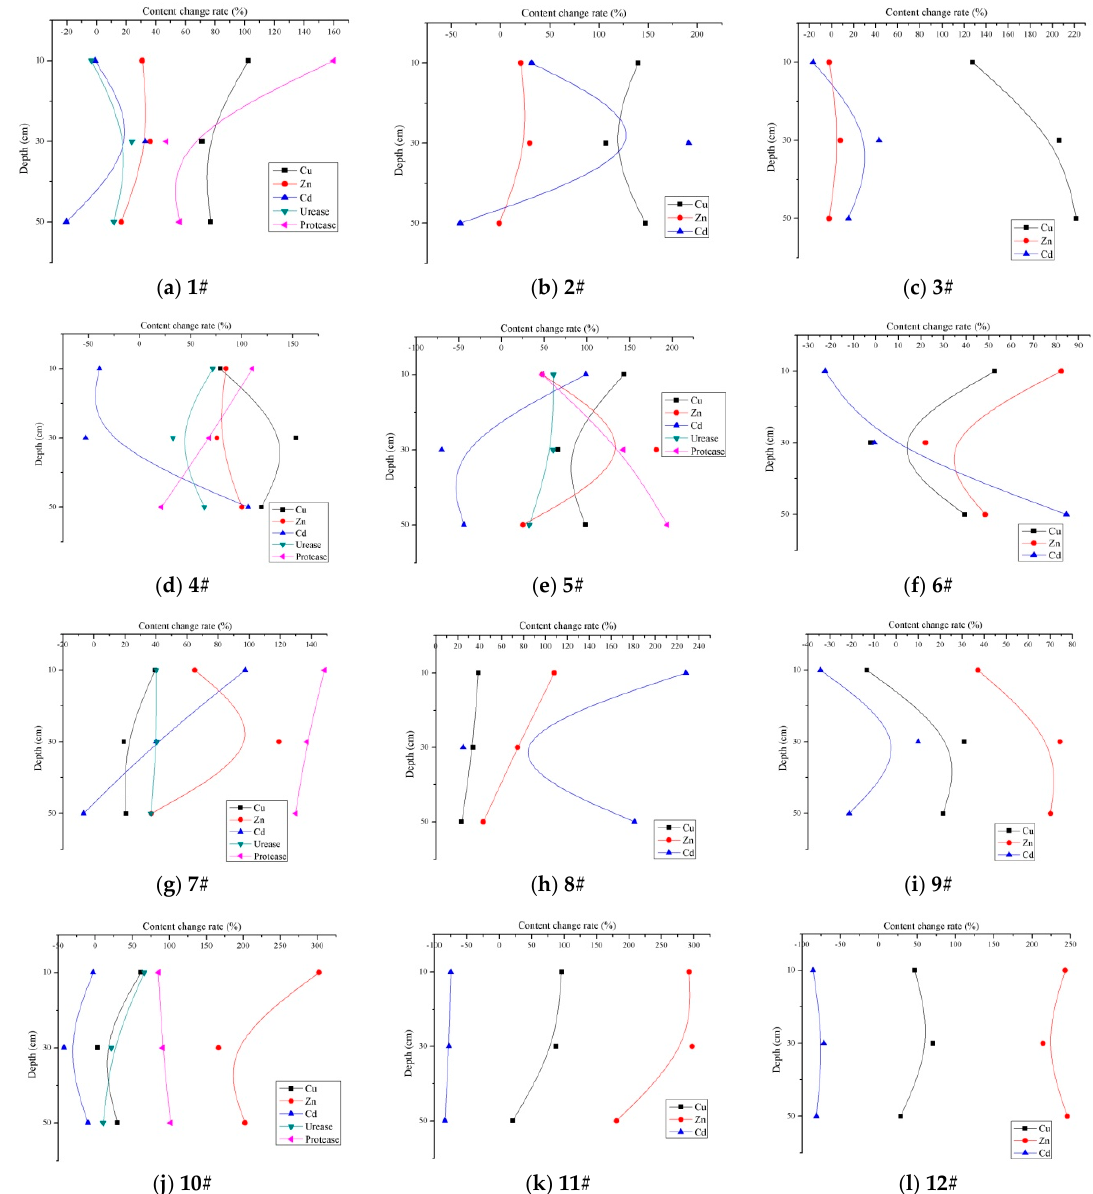
Figure 7. Content change rates of heavy metal/enzyme with depth; ( a ) 1#; ( b ) 2#; ( c ) 3#; ( d ) 4#; ( e ) 5#; ( f ) 6#; ( g ) 7#; ( h ) 8#; ( i ) 9#; ( j ) 10#; ( k ) 11#; ( l ) 12#.